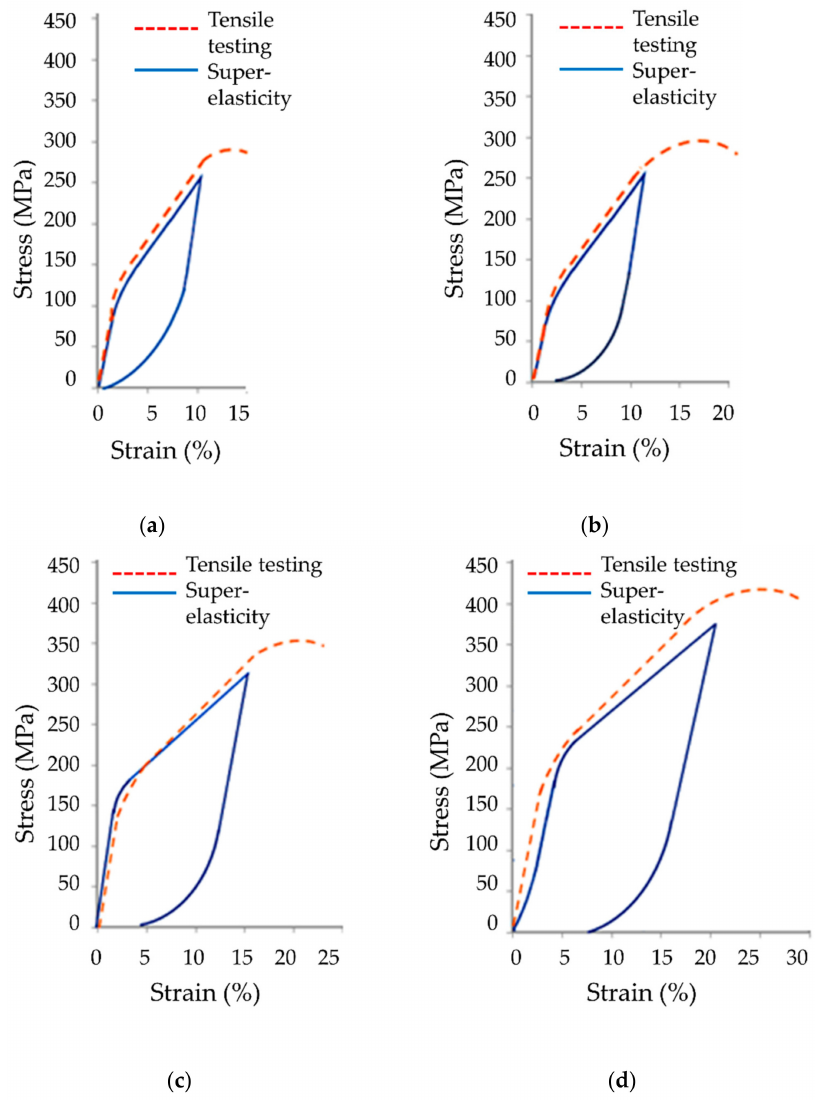
Figure 10. Stress–strain diagrams of tensile testing and super elasticity of ausforming- treated alloy with true plastic strain: ( a ) 0; ( b ) 20 %; ( c ) 98 %; ( d ) 151 %.